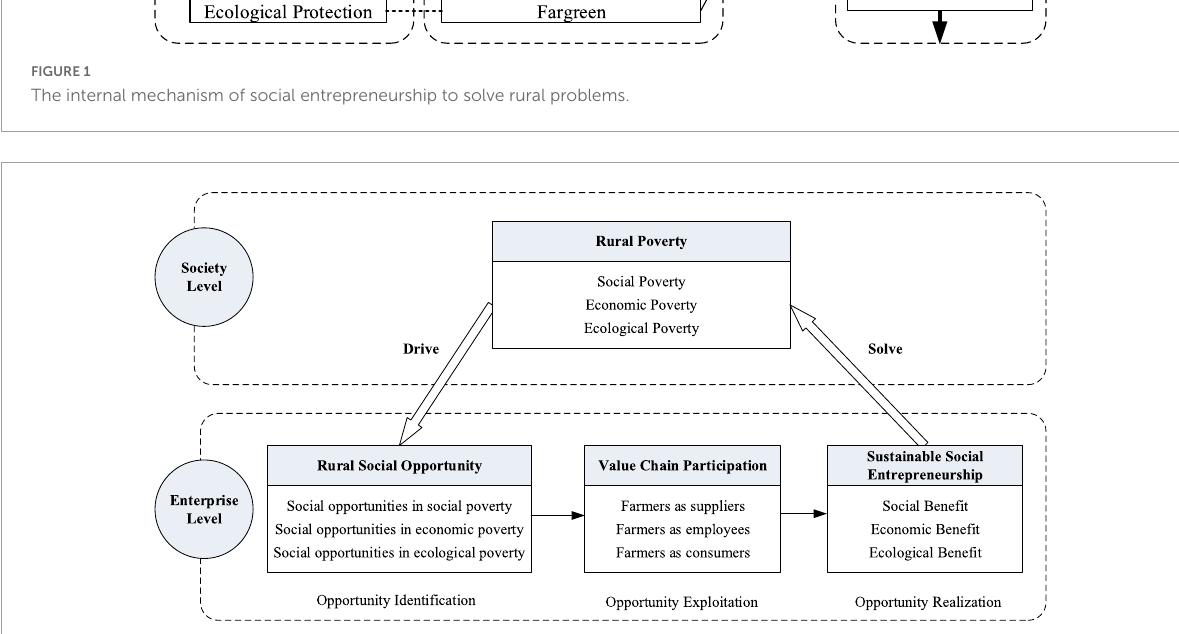
FIGURE1 The internal mechanism of social entrepreneurship to solve rural problems.